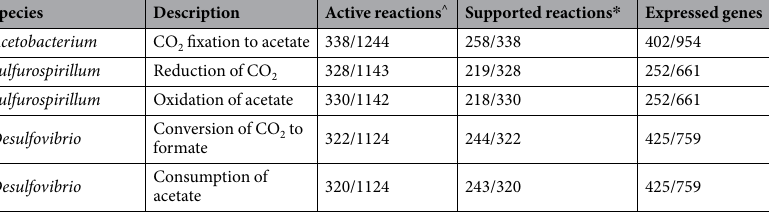
Table 1. Transcriptome support for metabolic activity predicted by models. ^ Active reactions only